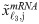
Boxplots of sample singular value vectors xℓ3,j (a) when TD was applied to the type I tensor and x˜l3,jmRNA (b), x˜l3,jmiRNA (c), 1 ≤ ℓ3 ≤ 5, when TD was applied to the type II tensor, generated from mRNA and miRNA expression profiles of multi-omics datasets. (d) Sample singular value vectors when HO GSVD was applied to multi-omics datasets. P-values computed by categorical regression attributed to (a) to (d) were below the figures.